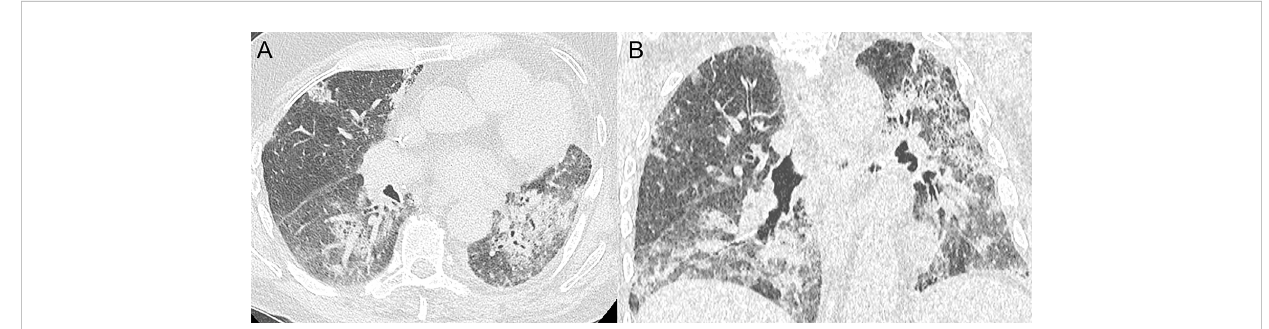
FIGURE 3 Immune-related pneumonitis in a 79-year-old male with stage IV non-small cell lung cancer in the left lower lobe. After second line treatment with nivolumab (anti-PD-1) (5 cycles), the patient developed progressive dyspnea and dry cough. Axial (A) and coronal (B) CT images demonstrate multifocal alveolar consolidations in a predominantly peribronchovascular and subpleural location compatible with a drug-induced